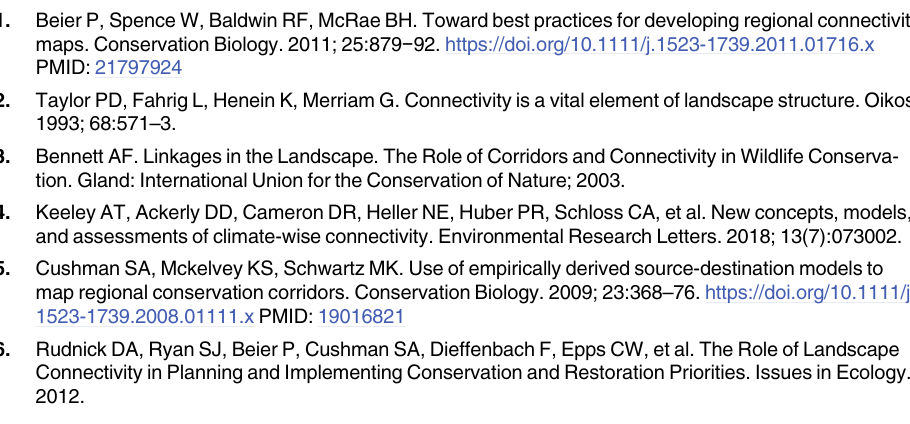
S1 Fig. Identified linkages with two types of resistance surfaces for five species. The resis- tance surfaces were based on species distribution models and expert-assigned scores. The five species are Bougainville’s skink, fuscous honeyeater, grey shrike-thrush, jacky lizard and rufous whistler. Habitat patches are shown in green, and least-cost paths are shown with blue lines. S2 Fig. Identified linkages with two types of resistance surfaces for five species. The resis- tance surfaces were based on species distribution models and expert-assigned scores. The five species are sugar glider, tree goanna, wood gecko, white-throated treecreeper and yellow- footed antechinus. Habitat patches are shown in green, and least-cost paths are shown with blue